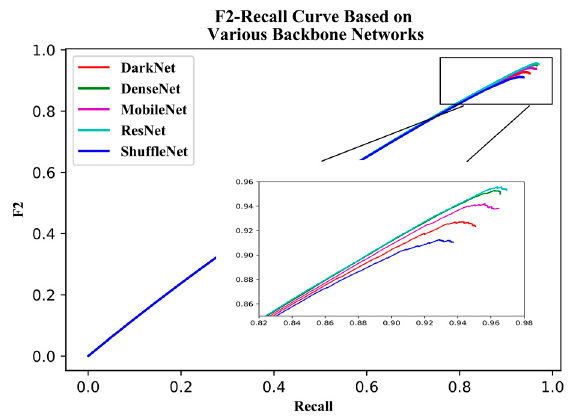
Figure 11. F2 Score-Recall curve of YOLOv3 based on various backbone networks.